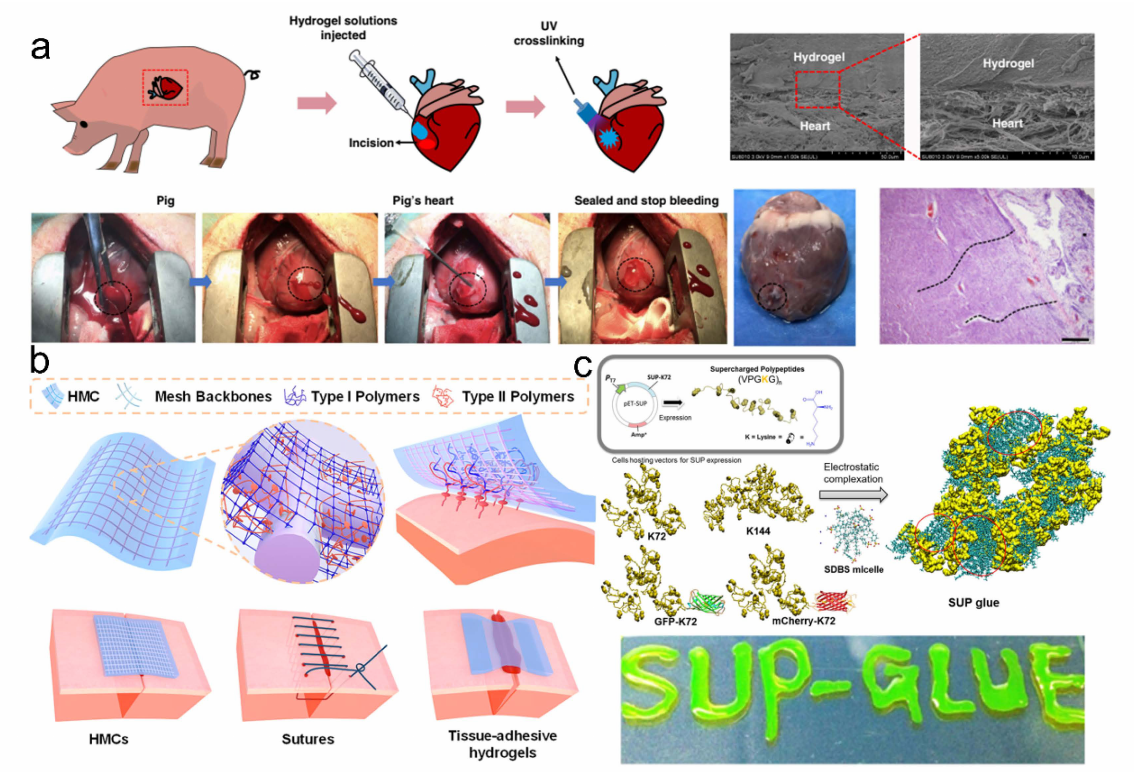
Figure 5. ( a ) A hemostatic adhesive hydrogel showed quick gelation and strong adhesion to the tissues within seconds after UV light exposure, which could prevent high-pressure bleeding from the big incision wound of pig hearts. Scale bar of the tissue staining image was 200 µ m. ( b ) The hydrogel-mesh composite with robust adhesion on tissues via non-covalent and covalent interactions, showing excellent wound hemostasis and healing. Reproduced with permission [59]. Copyright 2021, National Academy of Sciences. ( c ) Polypeptides adhesives assembled by multiple supramolecular interactions showed suitable biocompatibility, biodegradability, and strong adhesion on the soft tissues and stiff